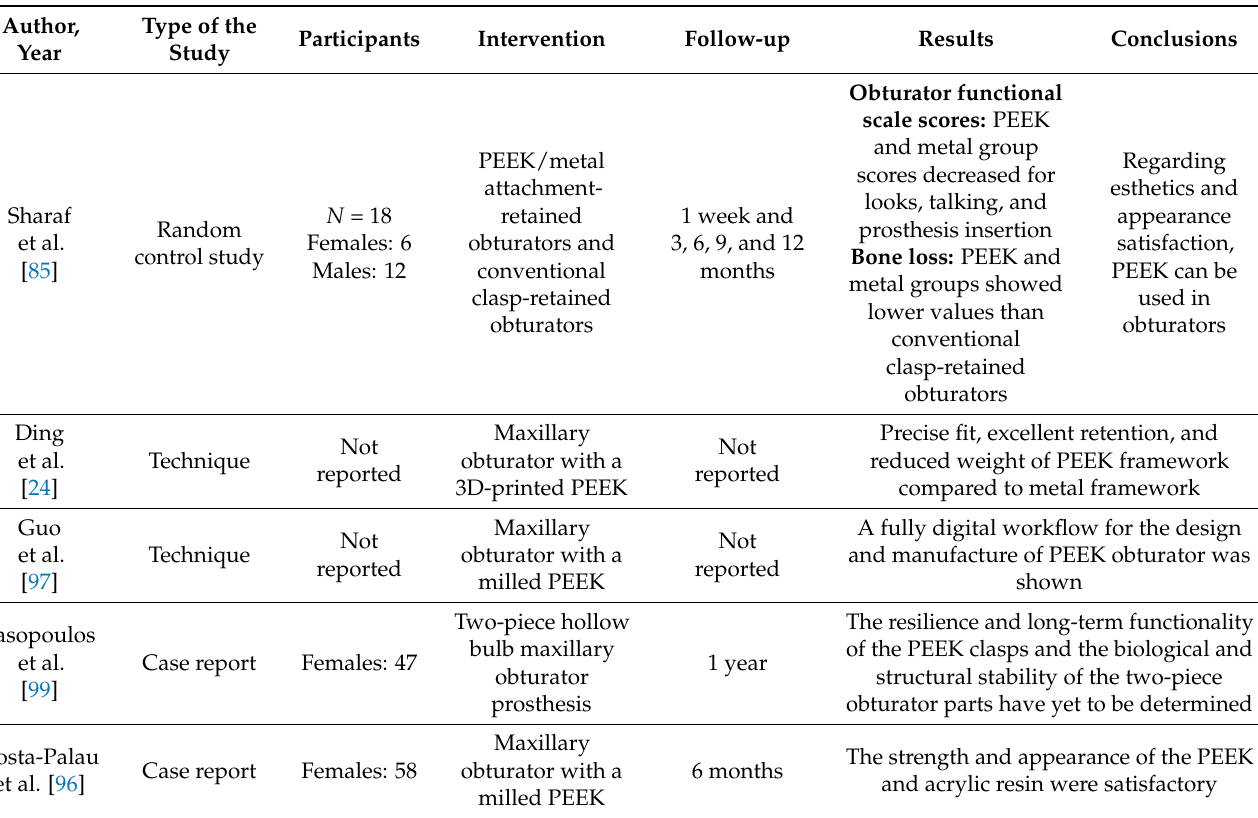
Table 3. Clinical studies on obturator